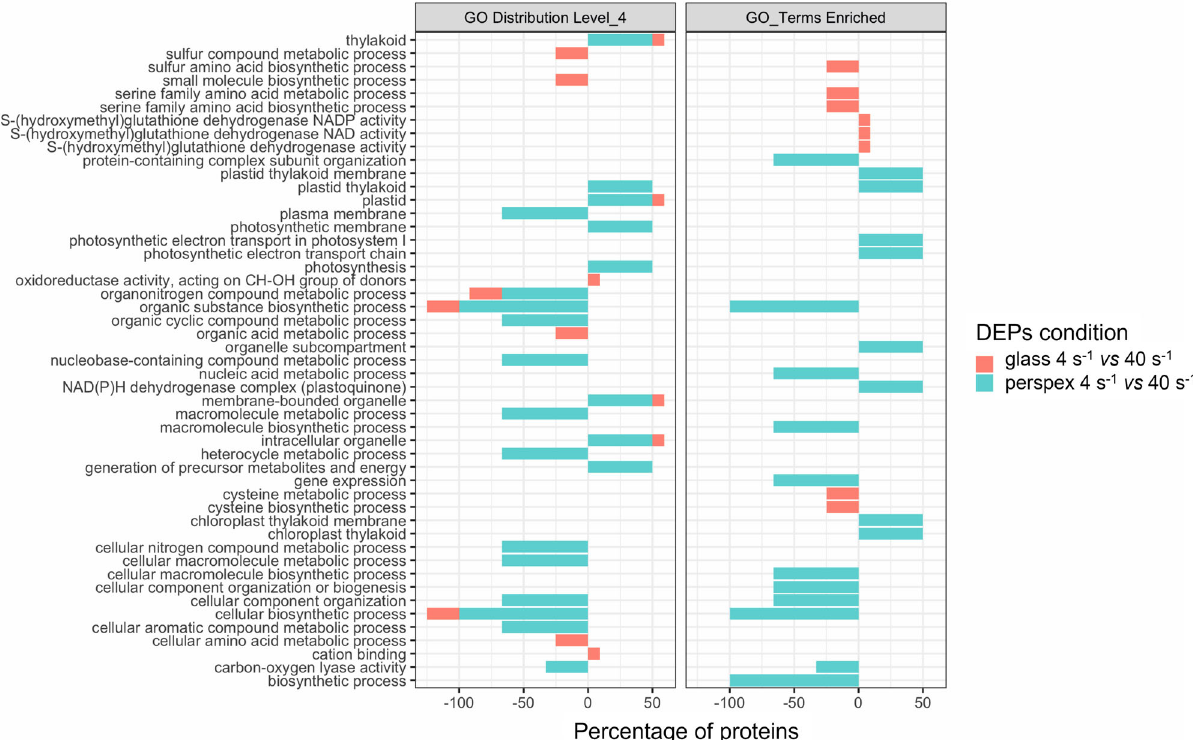
Fig. 7 Gene Ontology (GO) distribution and GO enrichment of Differentially Expressed Proteins (DEPs). In the left panel is shown the GO distribution by level 4 of the DEPs, whereas the right panel displays the corresponding enriched GO terms. The divergent stacked bars (negative and positive) represent the percentage of DEPs (x-axis) matching each GO Category (y-axis), relative to the number of DEPs found at both sides (up/down) of the tested conditions (DEPs Conditions). The total number of DEPs obtained from each comparison were 11-up/4- down (from glass 4 s − 1 vs. 40 s − 1 ) and 2-up/3-down (from perspex 4 s − 1 vs. 40 s − 1 ). The GO annotation was performed with the OmicsBox software version 1.4.11, as well as the enrichment analyses (Fisher ’ s exact test, P <